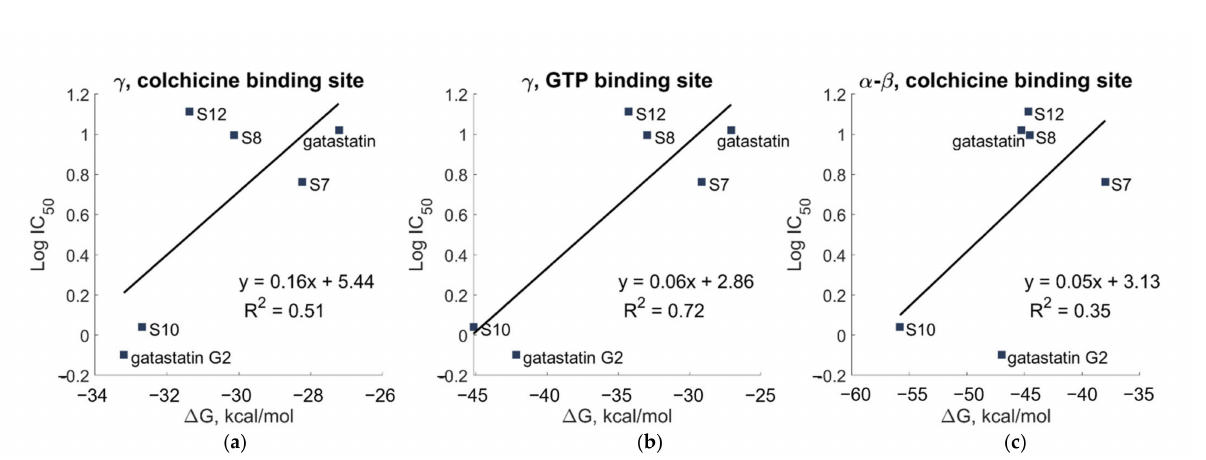
Figure 10. Scatterplot of binding free energy estimated from tryptophan fluorescence assay versus those calculated by MM/GBSA ( a ) for the putative colchicine-binding site on γ , ( b ) for the GTP- binding site on γ , and ( c ) for the colchicine-binding site of α - β tubulin. The correlation between the IC 50 values resulting from the cytotoxicity assay on HeLa cells [12] and the computationally predicted binding energies on γ and α - β tubulin is shown in Figure 11.